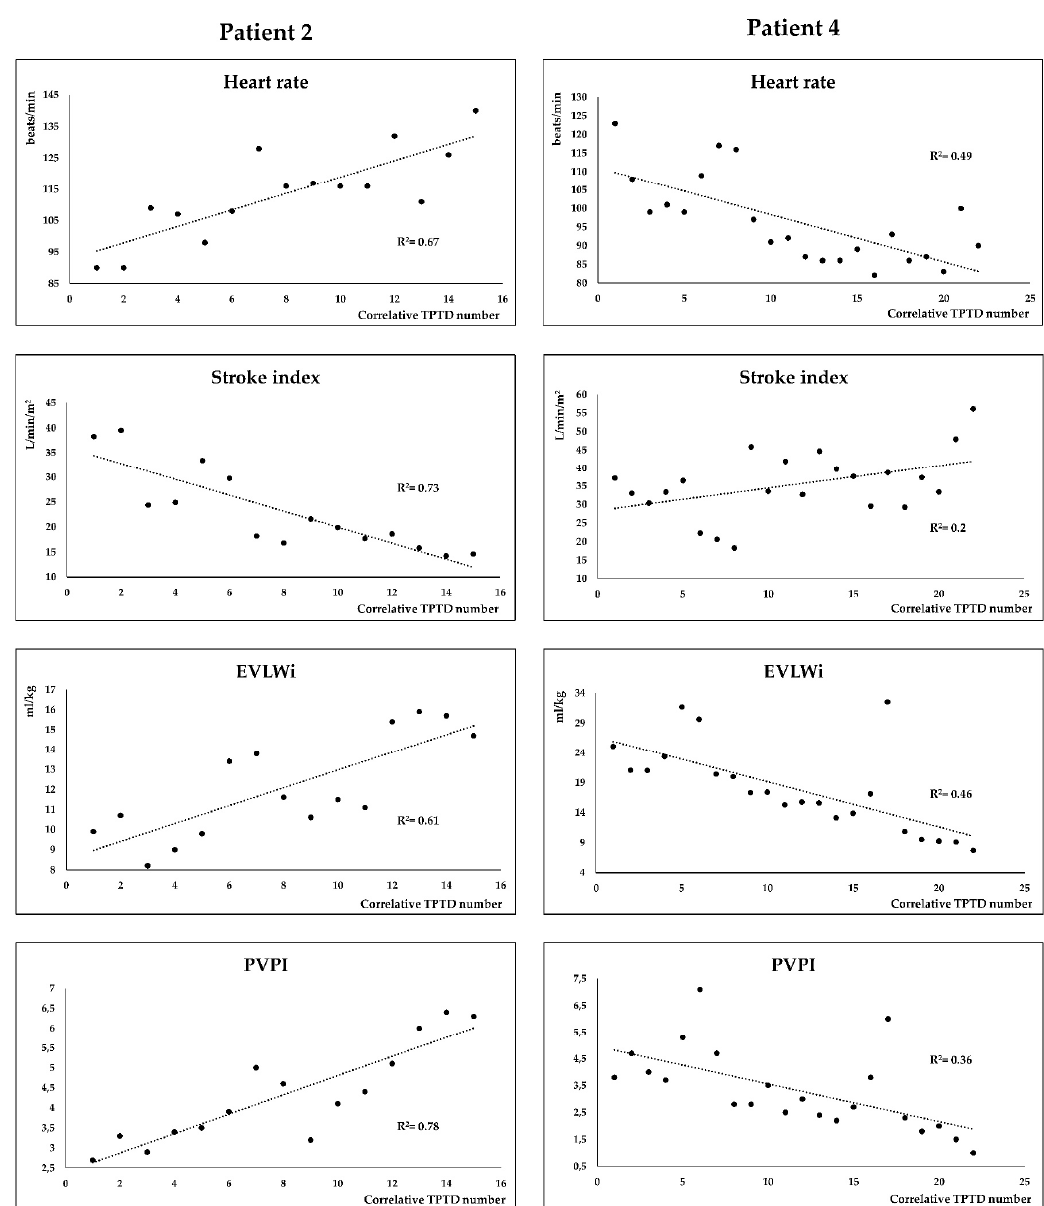
Figure 2. Time course of heart rate (HR), systolic index (SI), extravascular lung water index (EVLWi) and pulmonary vascular permeability index (PVPI) in a representative patient that required veno-arterial extracorporeal membrane oxygenation (VA-ECMO) (Patient 2) and in a representative patient that did not require VA-ECMO support (Patient